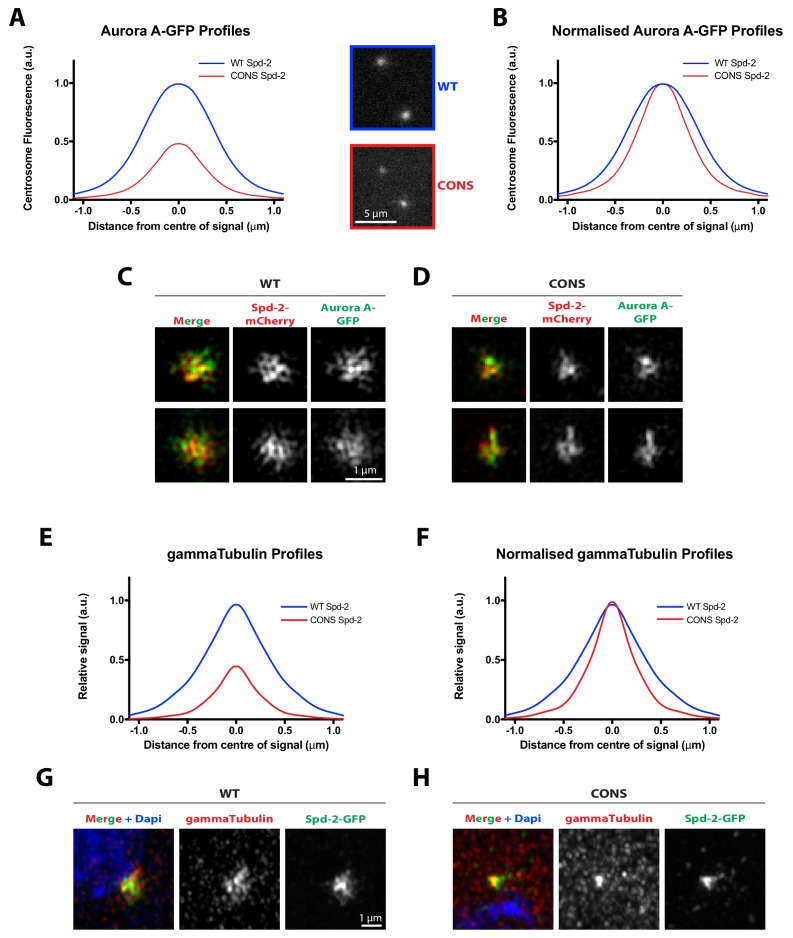
Evidence that the entire mitotic PCM does not expand outwards around the mother centriole in Spd-2-CONS embryos.(A) Graph compares the radial distribution of the PCM component Aurora-A-GFP around the mother centriole in living WT Spd-2-mCherry (blue) and Spd-2-CONS-mCherry embryos (red). Insets show examples of typical spinning disk-confocal images used for this analysis; five centrosomes per embryo were analysed, n = 4 and 8 embryos for WT and CONS embryos, respectively. (B) Graph shows the same data as shown in (A), but normalised so that the peak intensity of both genotypes = 1. This emphasises how even if the centrosomal Aurora A-GFP signal is normalised for fluorescence intensity, Aurora A-GFP spreads out around the mother centriole to a lesser extent in Spd-2-CONS-mCherry embryos than in WT Spd-2-mCherry embryos. (C,D) Micrographs show 3D-SIM images of individual centrosomes from Spd-2 mutant embryos expressing Aurora A-GFP (green in merged images) and either WT Spd-2-mCherry (C) or Spd-2-CONS-mCherry (D) (red in merged images). (E–F) Same analysis as presented in panels (A–B), but analysing the distribution of the PCM component ɣ-tubulin in fixed embryos. For radial profiles, we analysed 1 pair of centrosomes per embryo, five embryos per technical replicate (embryos collected and processed independently), and three technical replicates, total n = 15 embryos per condition. (G–H) Micrographs show Airyscan images of individual centrosomes from Spd-2 mutant embryos expressing WT Spd-2-GFP (G) or Spd-2-CONS-GFP (H) (green in merged images) stained with an anti-ɣ-tubulin antibody (red) and DAPI (blue in merged images.10.7554/eLife.50130.030Figure 7—figure supplement 1—source data 1.Figure 7—figure supplement 1A,B source data; radial profile analysis.10.7554/eLife.50130.031Figure 7—figure supplement 1—source data 2.Figure 7—figure supplement 1E,F source data; radial profile analysis.